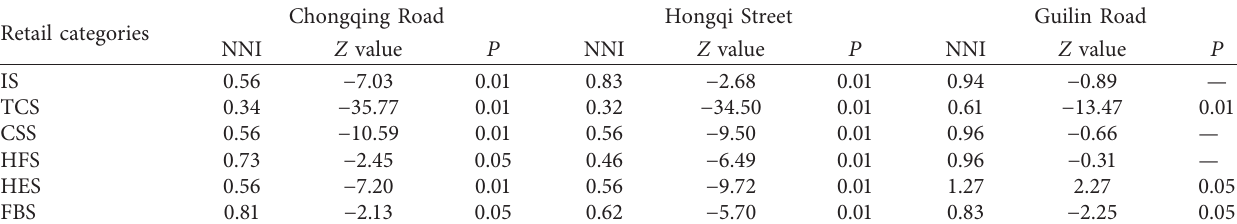
Table 2: NNI of retail categories in the three commercial districts in Changchun. Retail